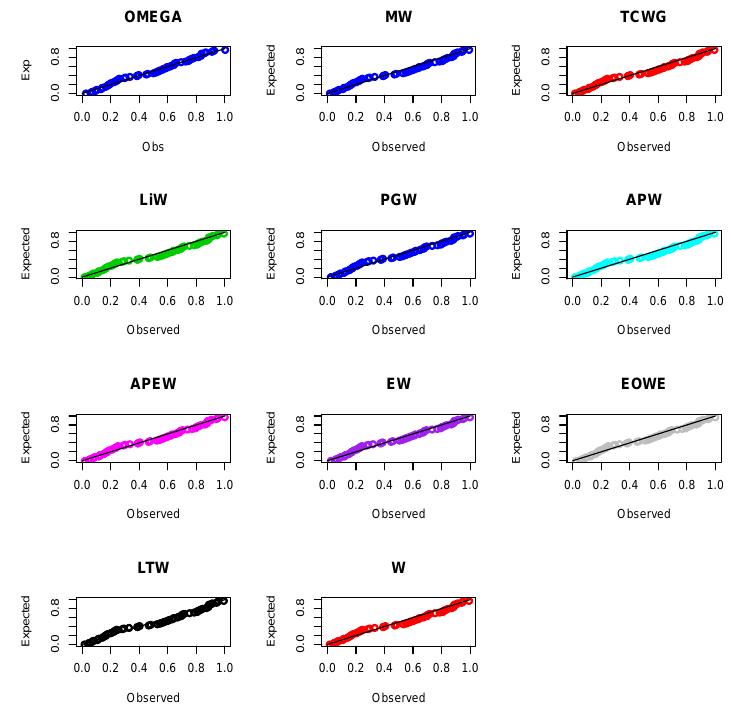
Figure 2. The PP plots of the fitted distributions.